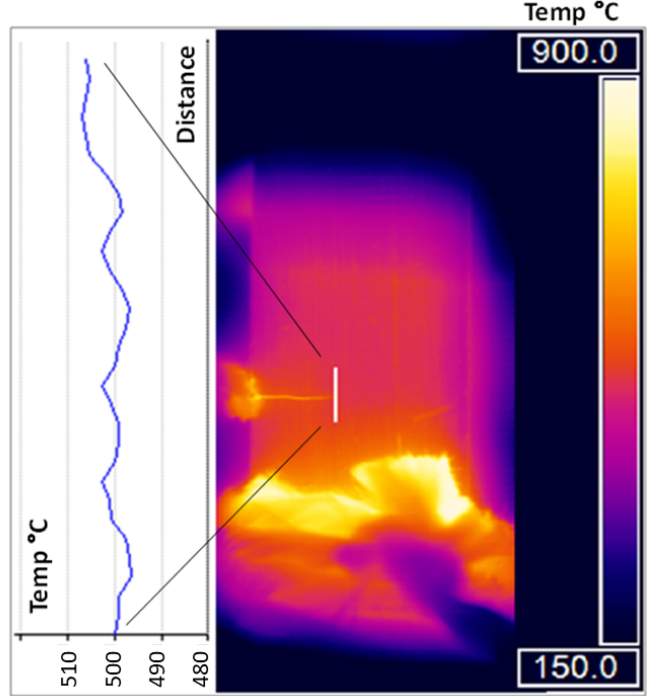
Figure 4. Thermographic image of Ti-6246 with crack plane at 500 ◦ C. Longitudinal profile indicates no effect of crack tip heating.